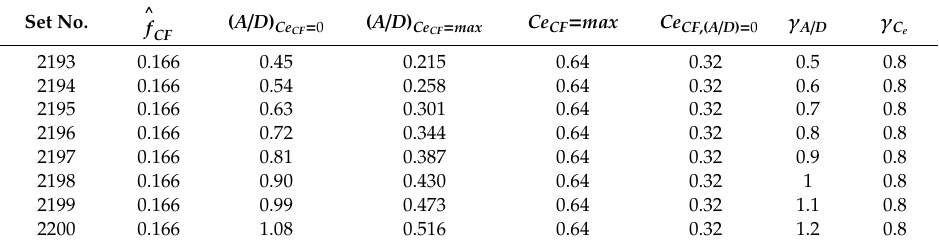
Table 2. New datasets of excitation coe ffi cient parameters for di ff erent modification factors. Set No.